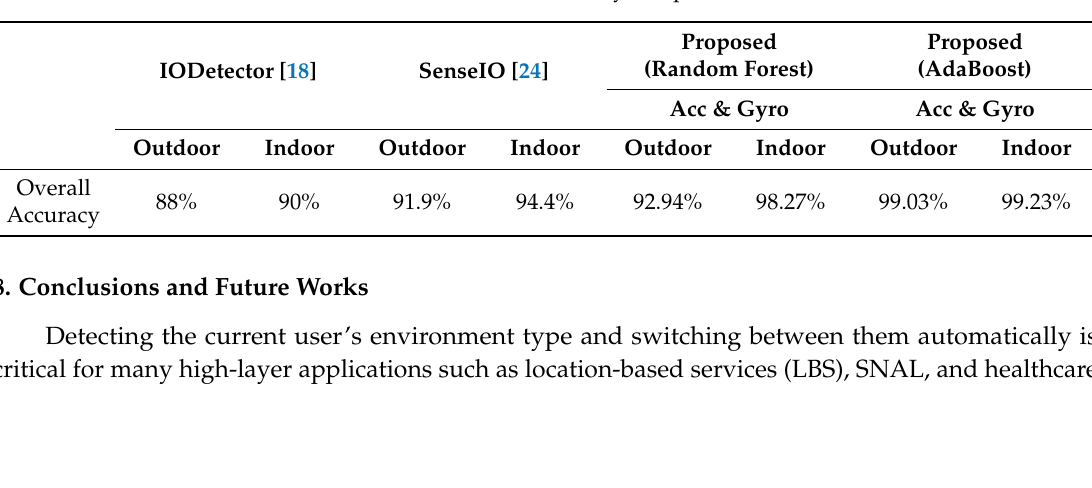
dataset in the selected-features scenario.